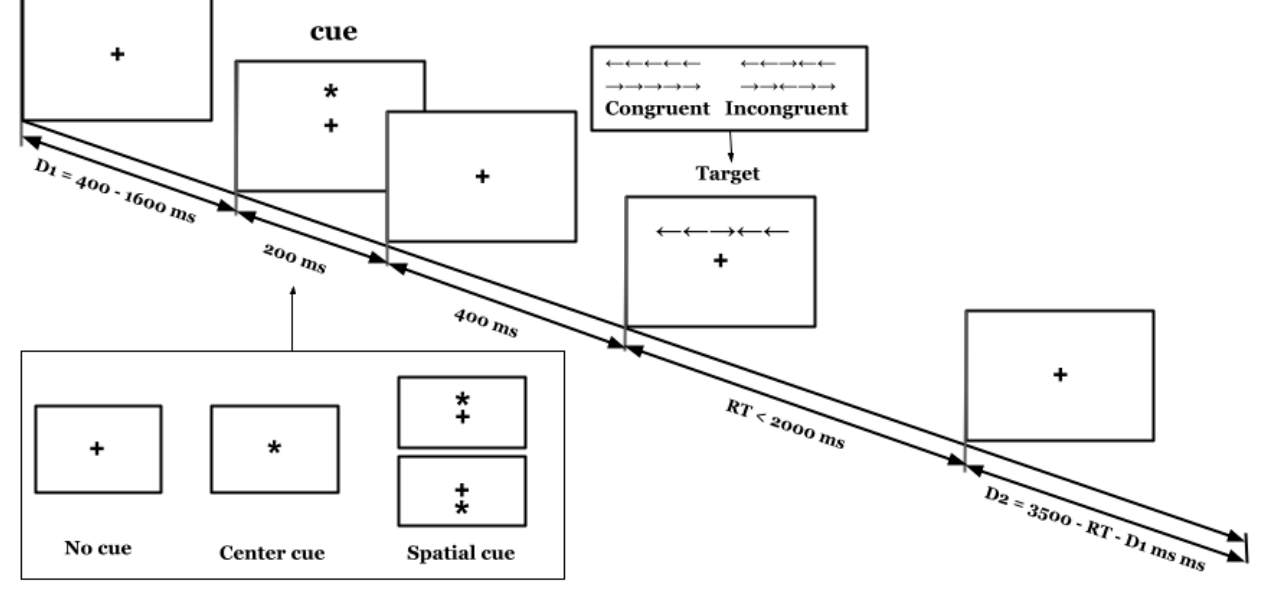
Figure 1. Schematic of the ANT. During the trial, a fixation cross was presented in the center of the screen and remained there the whole time. After a random duration D1 (400–1600 ms), a cue (none, center, or spatial cue) appears for 200 ms. After a 400-ms blank screen, a line of arrows with a target and flankers is presented (congruent or incongruent) above or under the fixation cross until the participant responds with a button press but for no longer than 2000 ms. Finally, a posttarget fixation period D2 is presented for a random duration.